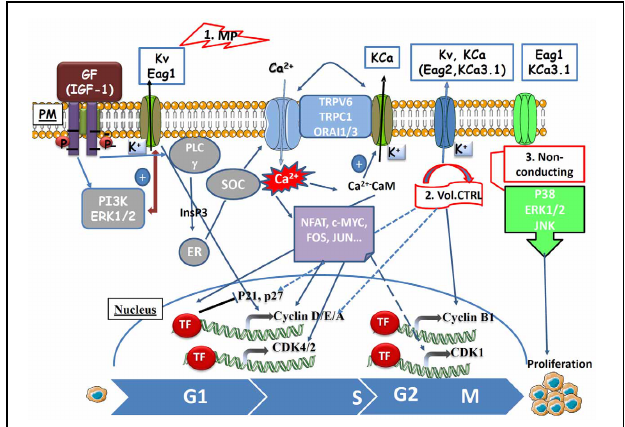
FIGURE 1 | Schematic illustration of the role of K + channels during cell cycle progression and proliferation. (1) Membrane potential model: during progression into G1 phase, the membrane potential becomes hyperpolarized relative to the normal resting potential. The hyperpolarization relates to Kv channels activation (for example Kv1.3, Eag1) in early G1 and to Ca 2 +− activated K + channels (for example KCa3.1) activation in late G1 and/or G1/S transition. Multiple growth factors in serum have been well-described to play an important role in initiating G1 progression to the S phase of the cell cycle, in which Ca 2 + influx is a major determinant in serum-induced DNA synthesis. Growth factors (for example IGF-1) binding to the receptor tyrosine kinases [RTKs; for example, Insulin growth factor receptor (IGF-1R)] can activate effectors [Extracellular signal-Regulated Kinase 1/2 (ERK1/2), phosphatidylinositol 3-kinase (PI3K)] that increase the expression and the activity of K + channels inducing a hyperpolarization of the membrane potential (MP). Moreover, RTKs also activate phospholipase C (PLC γ ) to promote the generation of inositol-1,4,5-trisphosphate (InsP3) and the release of Ca 2 + from the endoplasmic reticulum (ER) into the cytosol. Ca 2 + enters across plasma membrane by store-operated capacitive Ca 2 + entry (SOCE) through the ORAI1 (Hammadi et al., 2012) or ORAI3 (Faouzi et al., 2011) channels, through TRP Ca 2 + channels (for example TRPC1, El Hiani et al., 2009), or via the constitutively active TRPV6. The Ca 2 + entry, in turn, regulates the activity and/or the expression of Ca 2 + -activated K + channels (for example KCa3.1), which maintains the hyperpolarization promoting a significant Ca 2 + -entry. The increase in [Ca 2 + ]i triggers the activation of Ca 2 + -dependent signaling enzymes that may act by regulating the expression or activity of the transcription factors (TF), such as FOS, JUN, NFAT, C-MYC leading to the expression of cyclins and CDKs and the inhibition of the CDK inhibitor proteins (p27 KIP1 and p21 waf1 / cip1 ). (2) Volume control: K + channels in association with chloride channels regulate cell cycle progression by controlling the cell volume. For example, Eag2 channels controlM phase by regulating the expression of cyclin B1 through the p38 MAP Kinase pathway. (3) Non-conducting roles: K + channels may also promote cell proliferation independently of their ion permeation function. For example: Eag1 and KCa3.1 induce cell proliferation by (direct or indirect) interaction with MAP kinase signaling pathways (p38 for Eag1, ERK1/2, and JNK for KCa3.1). MP: membrane potential, (vol. CTRL): volume control, (PM): plasma